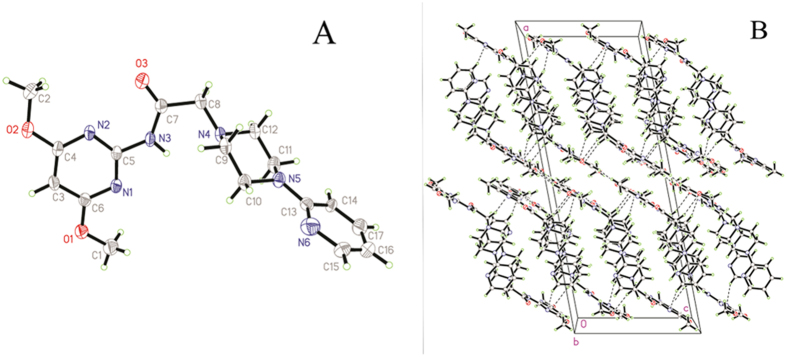
Crystal structure of compound 3m.(A) Molecular structure of compound 3m with atomic numbering scheme. (B) Crystal packing of the compound 3m.